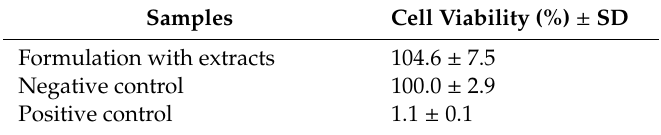
Table 5. Cell viability percentage of formulation with extracts by in vitro skin irritation